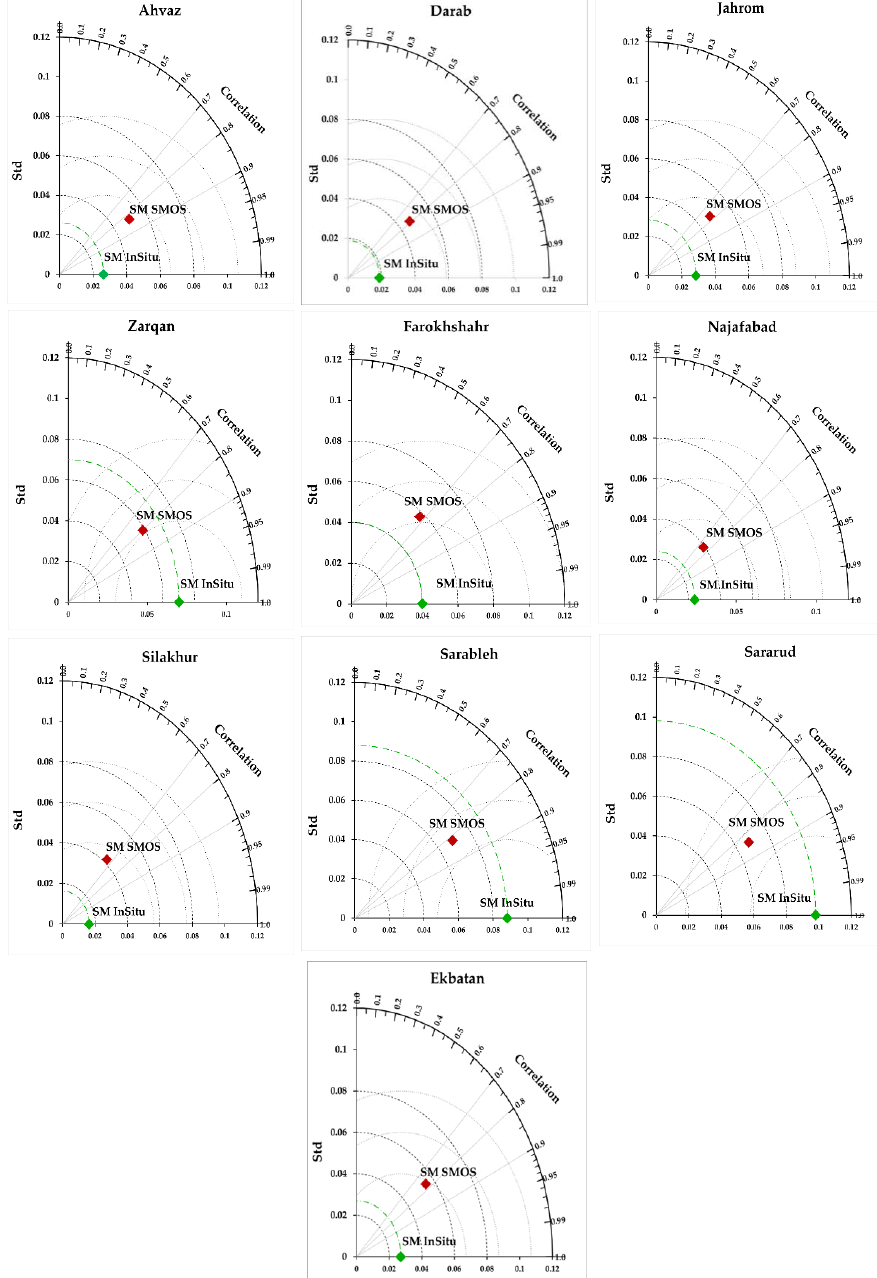
Figure 8. Taylor diagrams illustrating the statistics of the comparisons between SM SMOS and SM in situ data.